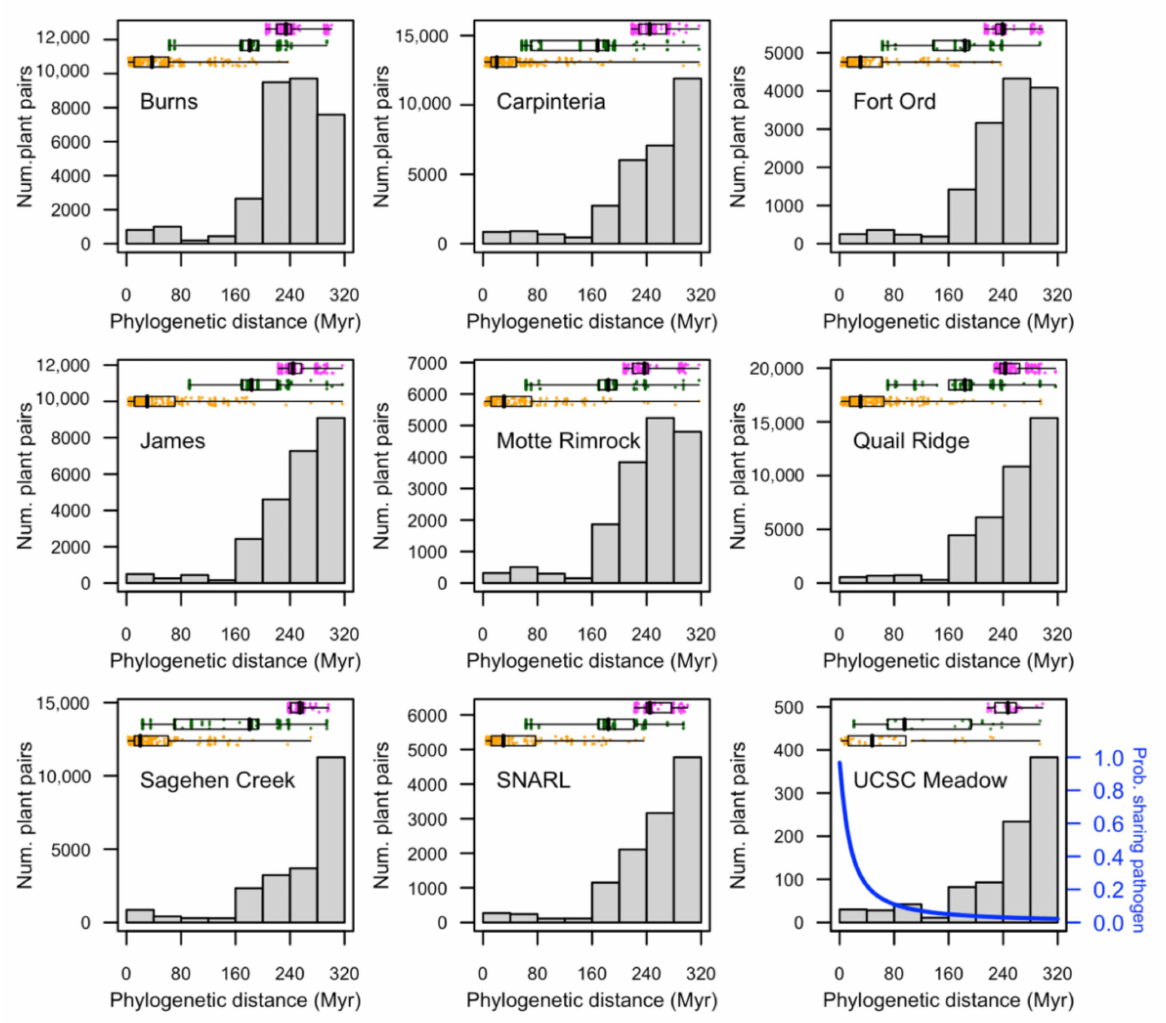
Figure 2. Features of the cumulative distribution of pairwise phylogenetic distances in plant com- munities. All pairwise phylogenetic distances were calculated for angiosperm plants in the UCSC Meadow (final panel, phylogenetic tree shown in Figure 1), and in each of eight UC Natural Reserves (species list in Table S1, and the R code to create phylogenetic trees from lists in ). Phylogenetic distances are given as Myr of independent evolution between pairs of plant taxa (2 × the time to the most recent common ancestor). Clouds of dots show the distributions of NTD (orange), PD10 (green), and meanPD (magenta) phylogenetic distances for all focal species in that community; associated box plots show the 25 th and 50 th quantile box, median thick line, and min and max whiskers. The blue curve in the UCSC Meadow panel indicates the empirically measured phylogenetic signal of host sharing, given as the probability that two plant species share a fungal pathogen at a given phylogenetic distance, where logit(pS) = 3.35861 − 2.857656 × log 10 (Myr + 1)